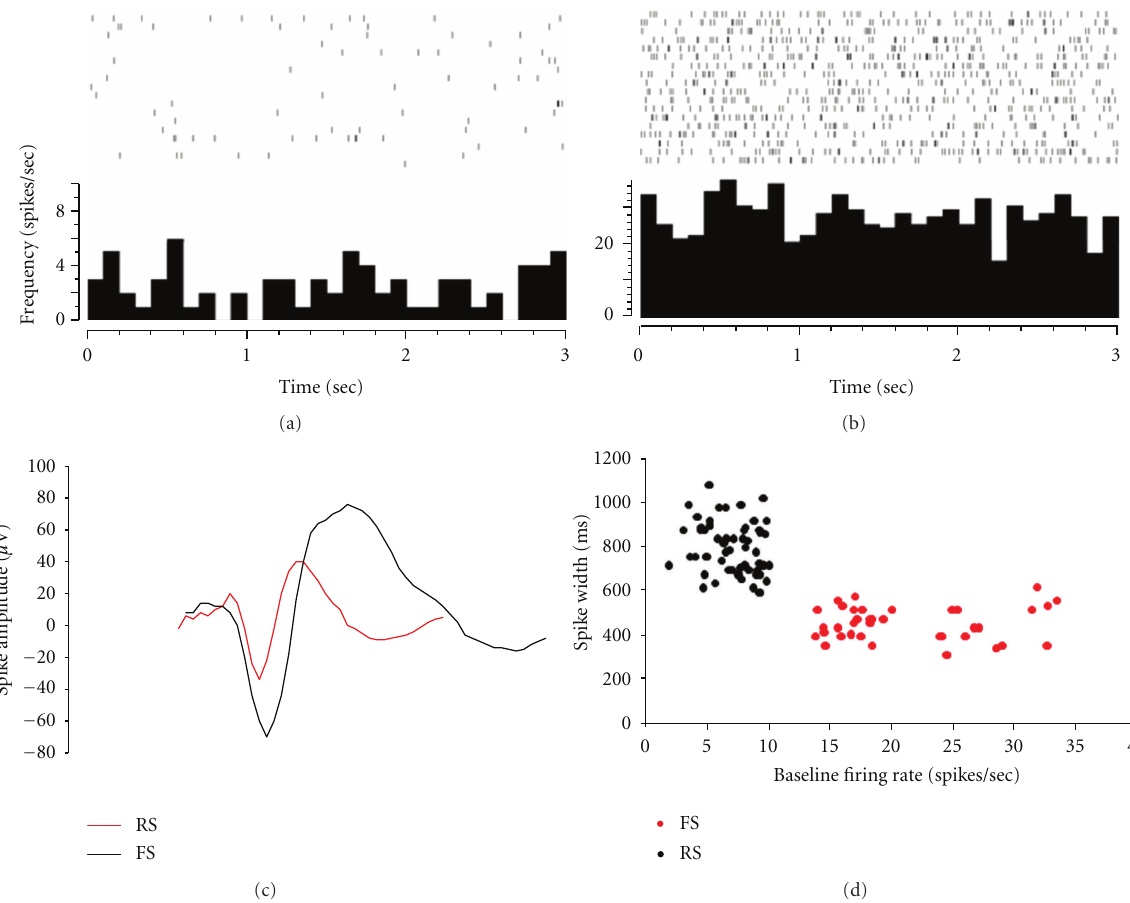
Figure 1: Classification of neurons. Two representative PETHs (bin size 100ms) illustrating typical neural firing rates during control periods in RS (a) and FS (b) neurons, note the lower mean firing rate in the RS neuron. Spike waveform analysis was also performed on these neurons (c), and di ff erences in spike duration between the averaged waveforms of isolated RS (black) and FS (red) neurons were easily identifiable. When spike duration was plotted against baseline firing rate for all of the neurons recorded from both animals, two distinctly separate clusters emerged (d). Based upon the previously established extracellular criteria, neurons were then classified as either RS (black) or FS